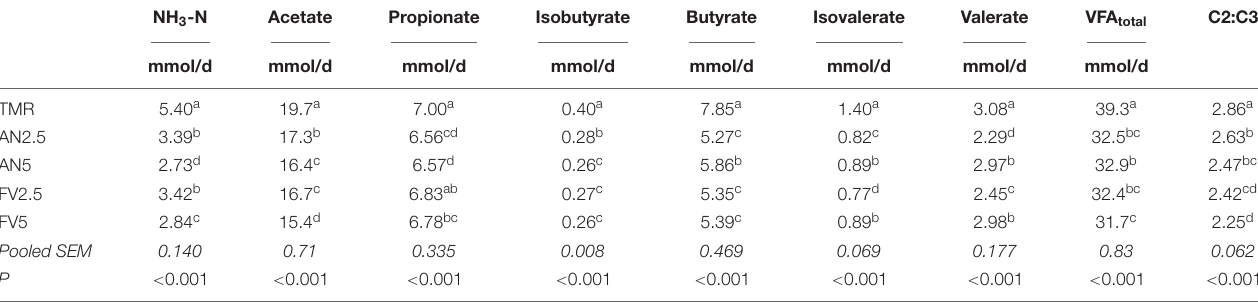
TABLE 4 | NH 3 -N and VFA production analyzed in the effluent of the five treatments (days 7–13). NH 3 -N Acetate Propionate Isobutyrate Butyrate Isovalerate Valerate VFA total C2:C3